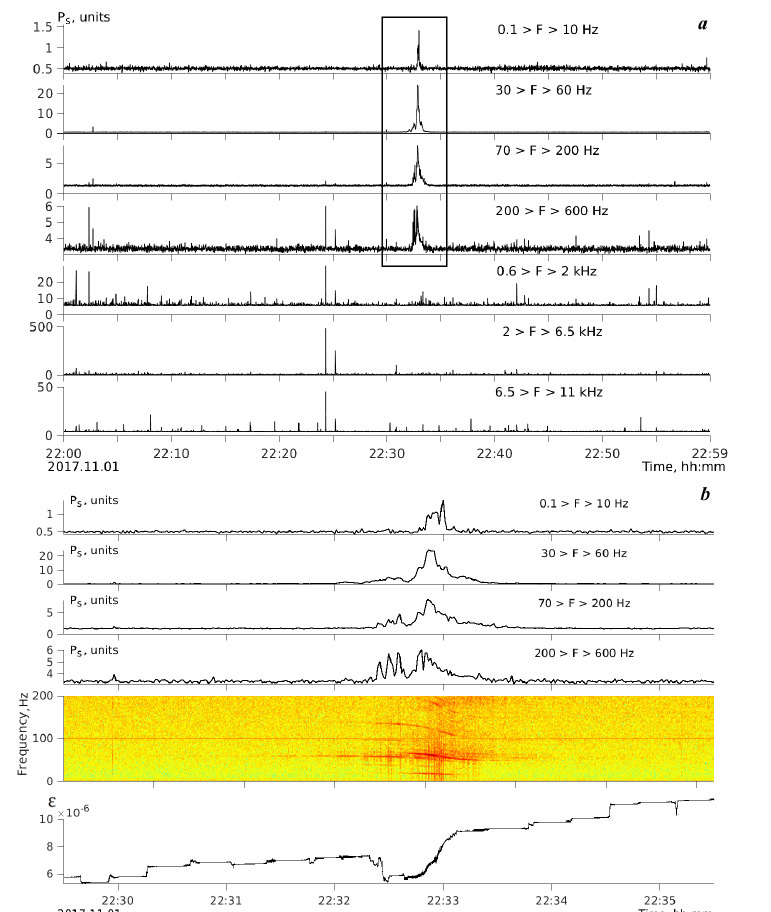
Figure 4: Geoacoustic signal variations P s recorded by the hydrophone № 1 of high-frequency geoacoustic system from 22:00 to 23:00 UT on November 1, 2017 (a). A record fragment of amplitude pulse jump of the acoustic signal which was also recorded in microbarometer and geophone signals (Fig. 2, 3) is marked by a rectangle. Development of the selected record fragment of amplitude pulse jump of acoustic signal P s in four frequency sub-ranges, its spec- trogram and rock relative deformation ε recorded by the laser strainmeter-interferometer (b)